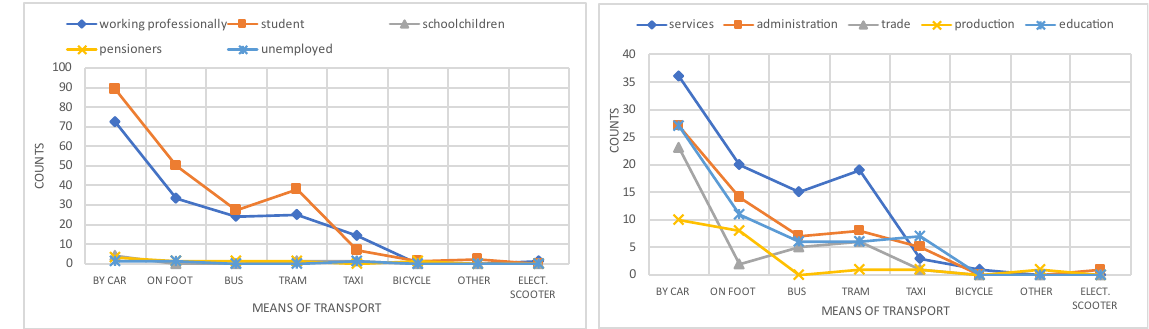
Figure 10. The choice of individual means of transport in the home – hospital direction.